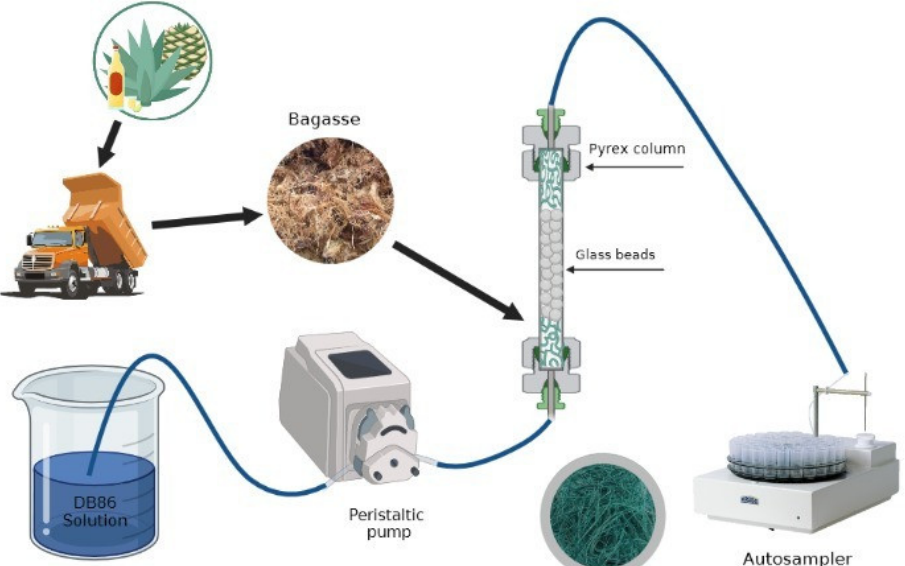
Figure 1. Experimental setup for fixed-bed column study. From the breakthrough curves obtained, breakthrough time (t b ), saturation time (t s ), height of the mass transfer zone (H MTZ ), adsorption capacity of the column at the break- through point (q b ), and the saturation time (q s ) were measured [23]. Additionally, the ki- netic models of Adams-Bohart and Thomas were studied to analyze the breakthrough curves of dye adsorption in the continuous mode. The equations used for each determi- nation are presented in Supplementary Table S2. Adsorption models (kinetic and isotherm) were analyzed by using non-linear equa- tions, using the Levenberg-Marquardt algorithm as an estimation method (convergence criterion: 1.0 × 10 −6 ). 2.3. Life Cycle Assessment (LCA) Study The LCA study followed the guidelines of the ISO 14040 [14] and 14044 [15] stand- ards. The methodological framework followed is described below. First phase: definition of the objective and scope of the particular LCA for the assess- ment of the environmental performance of adsorbents. The objective of this LCA study was to comparatively evaluate the potential environmental impacts of two adsorbents synthesized in the laboratory through different processes, that is, in two different ways. The scope of the study included the synthesis stages of the adsorbents and their respective use on a laboratory scale. The selected functional unit was of the physical type and was 1 kg of agave bagasse for the synthesis processes and the use of the respective adsorbent obtained. That is, the comparison was made from the same biomass. For the Life Cycle Impact Assessment (LCIA), the ReCiPe method was selected for easy interpretation and scientific robustness. This method can significantly reflect the po- tential environmental impact of the system under analysis through its varied and charac- teristic impact categories. RIVM, CML, PRé Consultants, Radboud Universiteit, Nijme- gen, and CE Delft created the ReCiPe methodology [24]. ReCiPe was developed to com- bine the advantages of the CML2001 (scientific soundness) and Eco-Indicator99 (ease of interpretation) methods. It is internationally accepted and is considered the successor of the previous methodologies. It integrates the environmental problem-oriented and the damage-oriented approaches. The categories selected in this research, according to the type of expected impacts, were climate change, fossil depletion, freshwater consumption, human toxicity, land use, photochemical ozone formation, and terrestrial ecotoxicity.